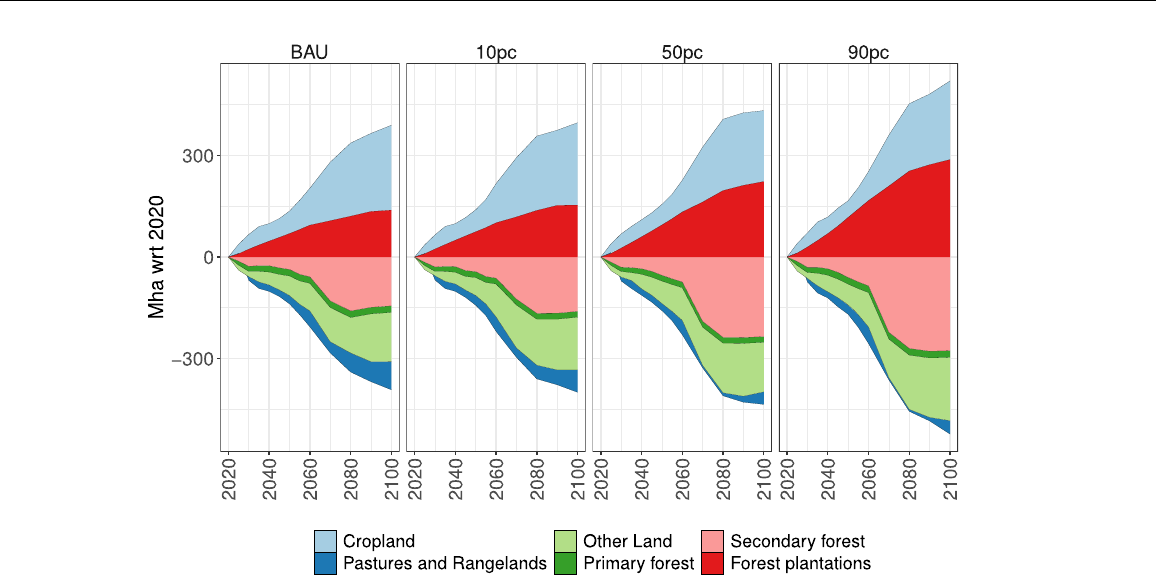
Fig. 2 | Comparitive changes in global land use between 2020 and 2100 (with respectto2020). Changesingloballanduseareshownforcropland,pasturesand rangelands, other land, primary forest, secondary forest, and forest plantations. Positivenumbersrepresentanexpansionofthelandareafortheindicatedland-use type compared to 2020, and negative numbers represent a reduction of land area